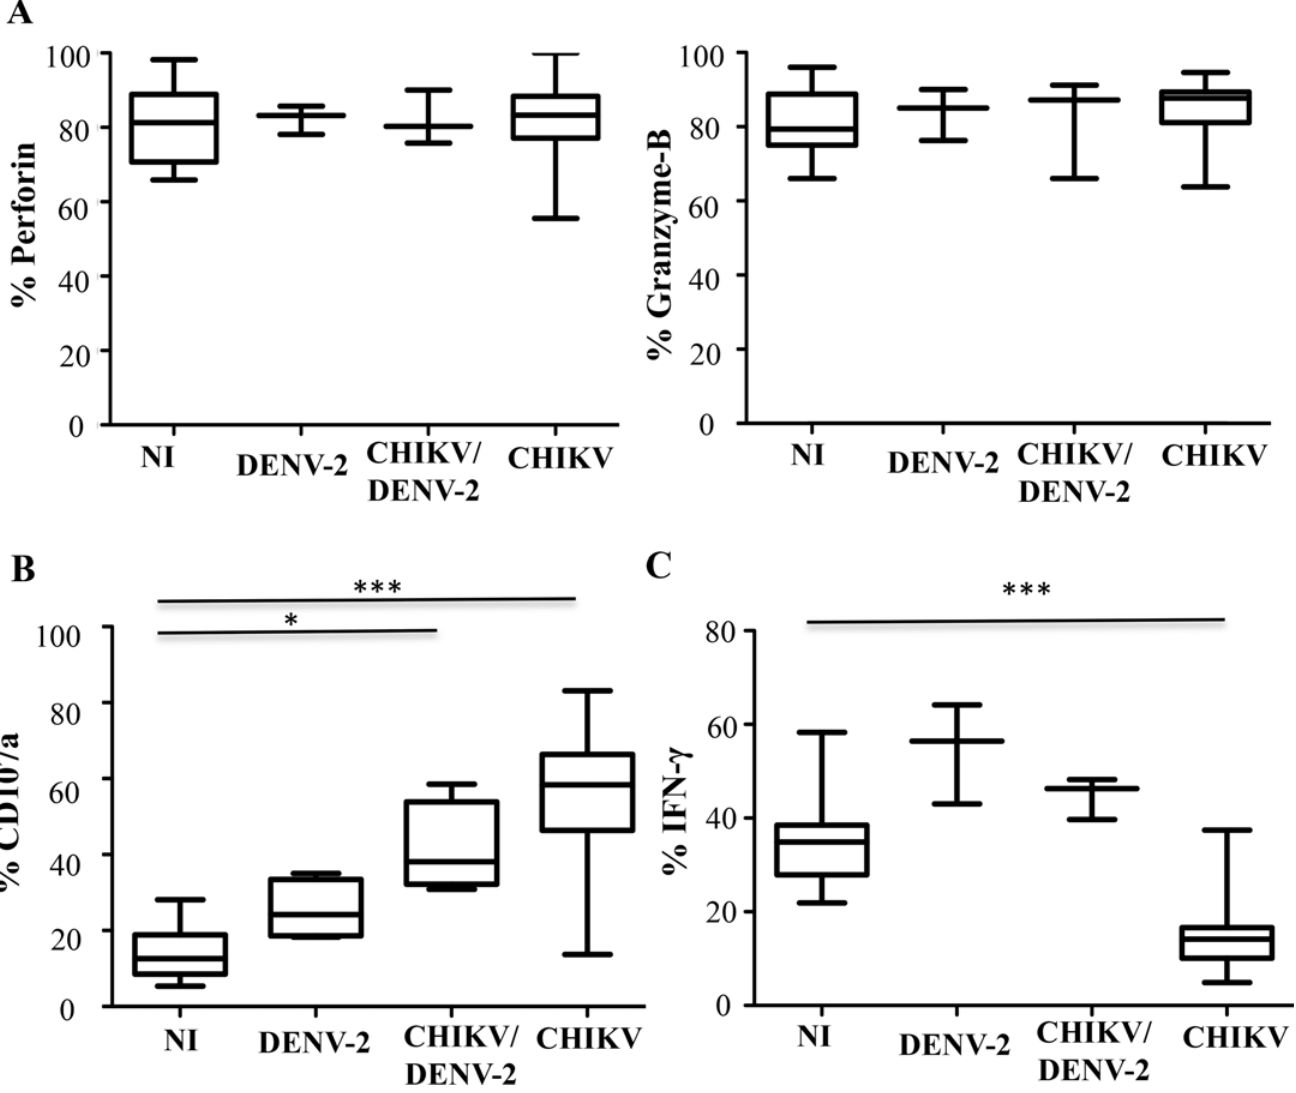
Fig 6. Cytolytic markers and functional activity of NK cells in patients infected with DENV-2, CHIKV, co-infected with CHIKV and DENV-2 (CHIKV/ DENV-2), and non-infected and healthy Gabonese controls (NI). Patients were tested at early acute (EA; day (D)0-D3) stage post-onset of symptoms. (A) Intracellular staining of perforin and granzyme-B cytolytic markers on non-activated CD3 - CD56 + NK cells. (B) CD107a expression on CD3 - CD56 + NK cells stimulated by K562 target cells. Results are shown for an effector/target (E/T) cell ratio of 1/1. (C) Intracellular staining of IFN- γ + in CD3 - CD56 + NK cells after IL-12 plus IL-18 overnight stimulation. * : p < 0.05; *** : p <